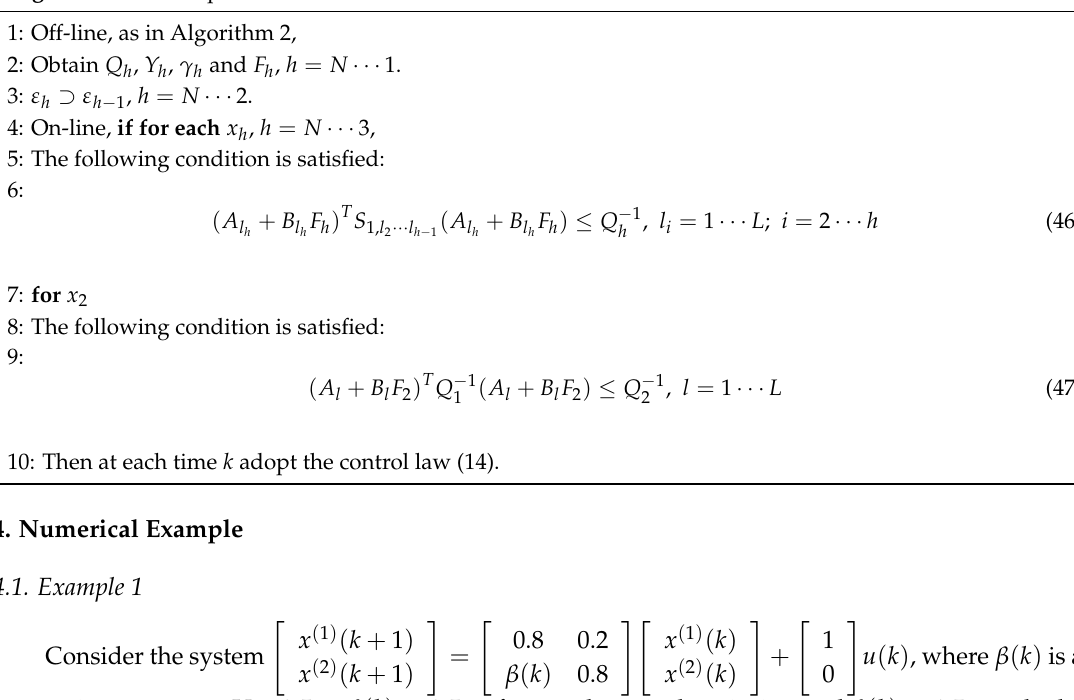
Algorithm 3 The Improved Off-Line MPC with an Automatic